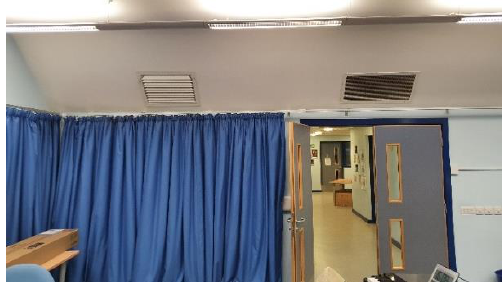
Figure 17. Picture of classroom D5.